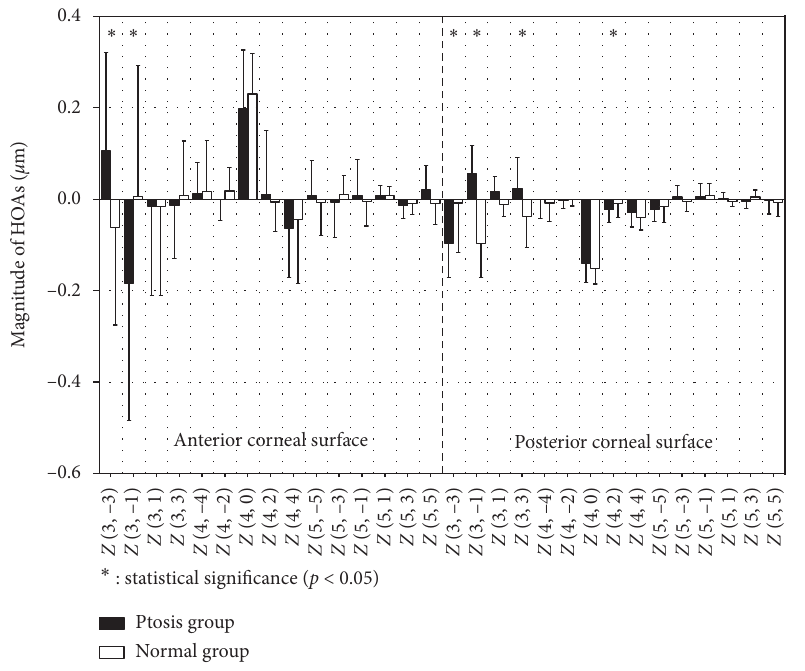
Figure 3: Comparisons of the Zernike coefficients (3rd to 5th order) of the anterior and posterior corneal surface between the ptosis group and the normal fellow group. Table 3: Comparison of the OQAS parameters between the ptosis group and the normal